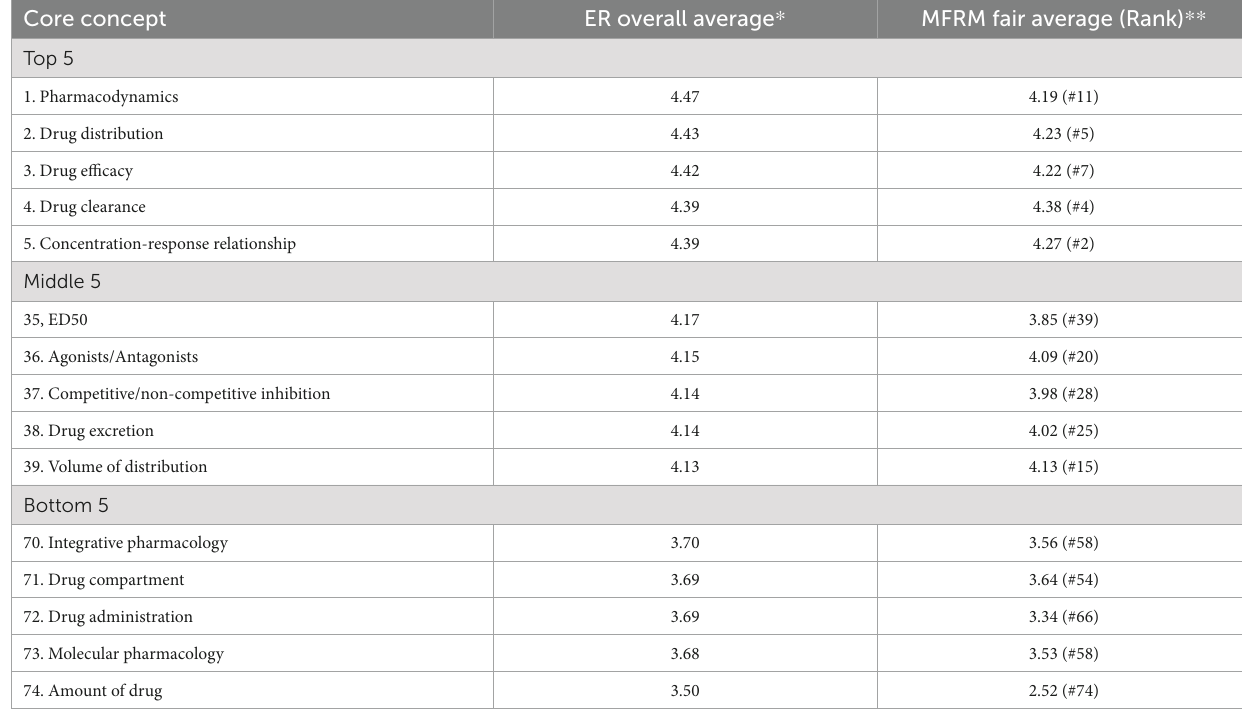
TABLE 4 Comparison of core concepts rankings from delphi expert ratings and MFRM with rater adjustments. Core